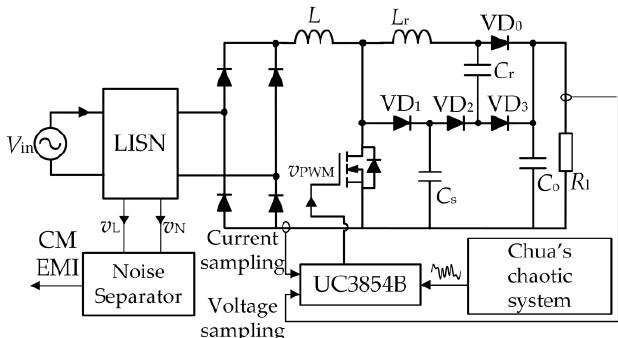
Figure 10. Circuit experiment.